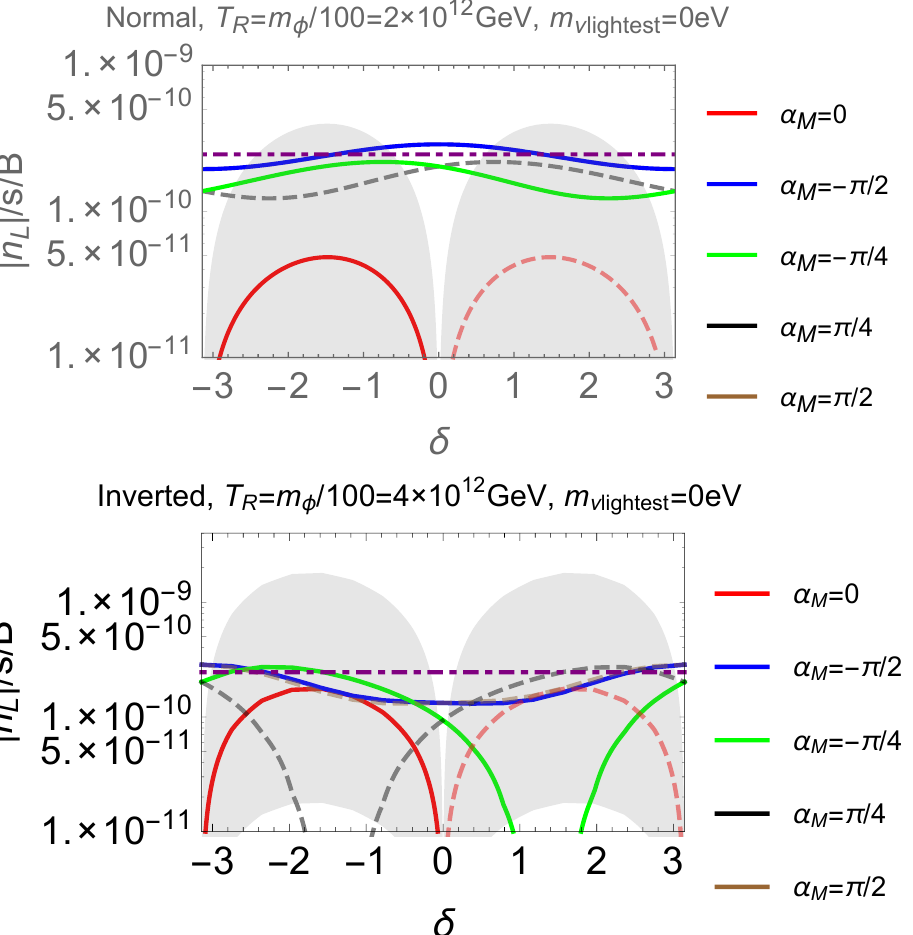
Figure 5 . Lepton asymmetry dependence on (cid:14) for in(cid:13)aton decay dominantly to Higgs boson. The uncertainty for (cid:11) M = 0 case is shown in the gray